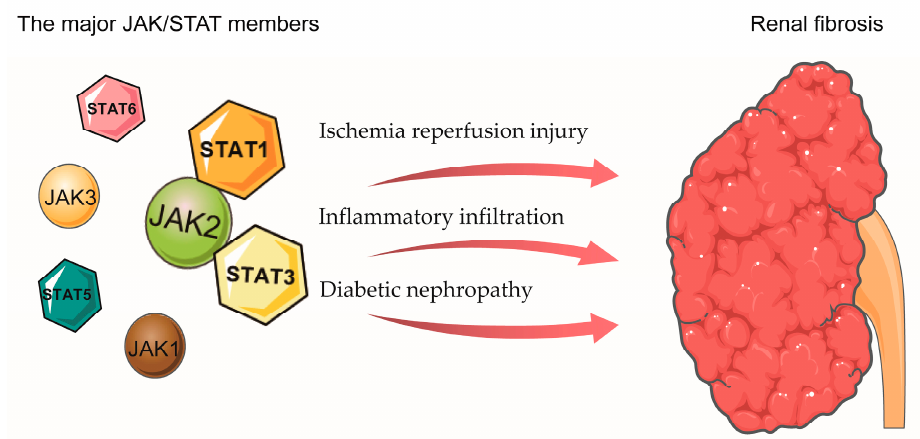
Figure 4. The role of JAK/STAT in renal fibrosis. Schematic illustrating the main JAK/STAT members may involve in renal fibrosis, primarily through ischemia reperfusion injury, inflammatory infiltration, and diabetic nephropathy to modulate renal fibrosis.